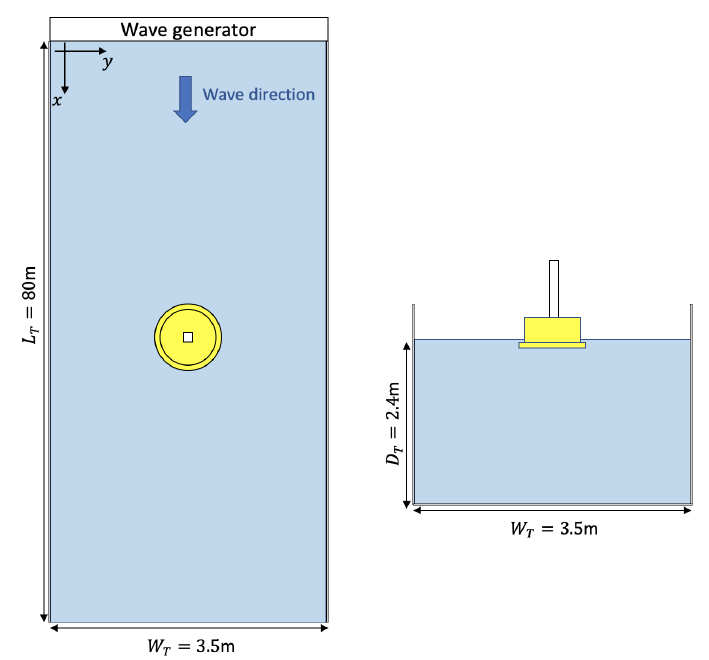
Figure 3. Top and front views of the wave tests setup in the towing